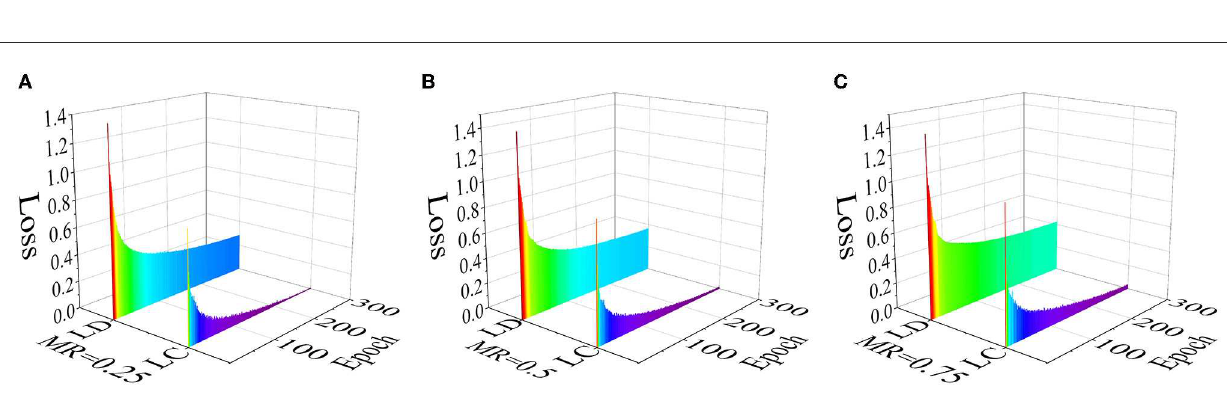
FIGURE7 Losses of three mask ratios. Each subgraph contains the loss of the Decoder (LD) to reconstruct image features and the loss of the classification (LC). (A) Mask ratio (MR) = 0.25; (B) Mask ratio (MR) = 0.5; (C) Mask ratio (MR) =